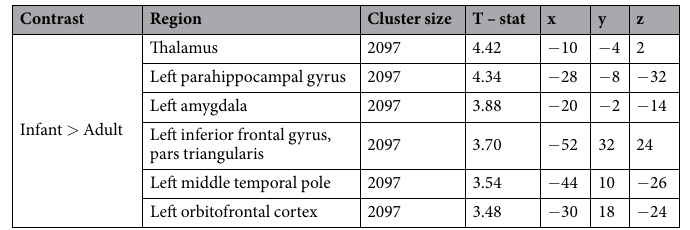
Table 4. Effects of duration of motherhood: regression analysis using infant age in months, applying cluster FWE correction (p < 0.05), across first-time mothers (N = 23). Labelling of peaks within the larger significant clusters was done using the AAL2 atlas in